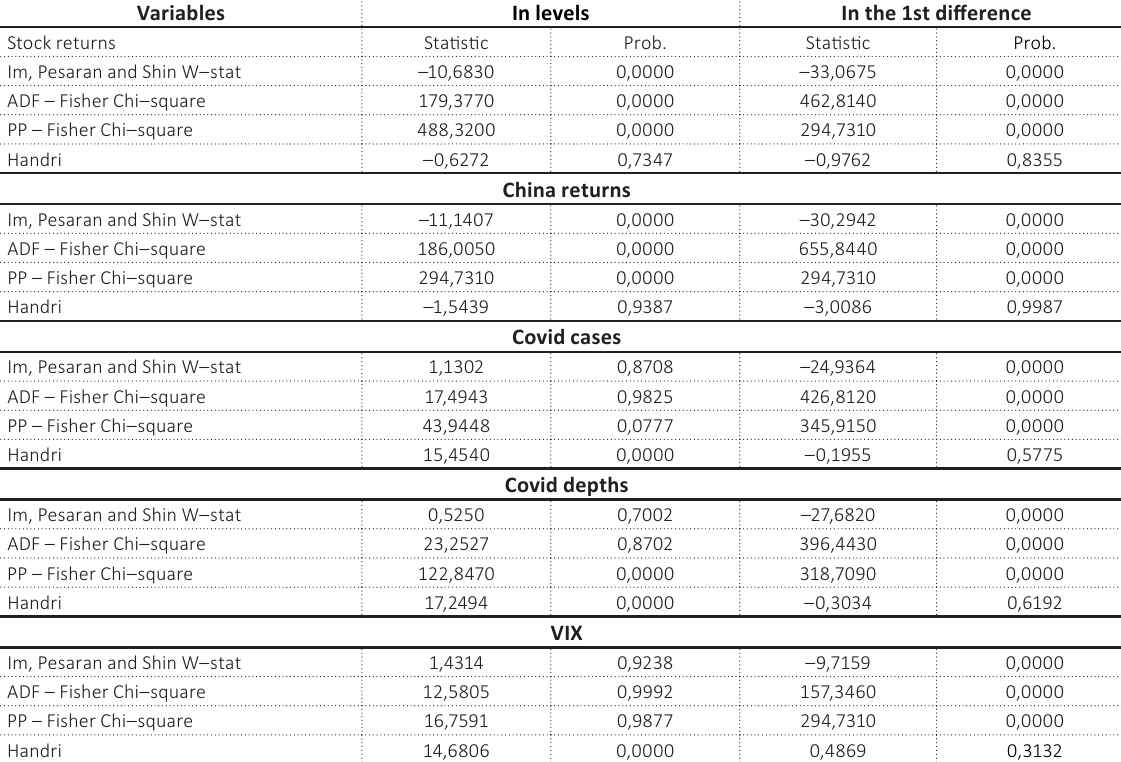
Table A3. Panel data unit root